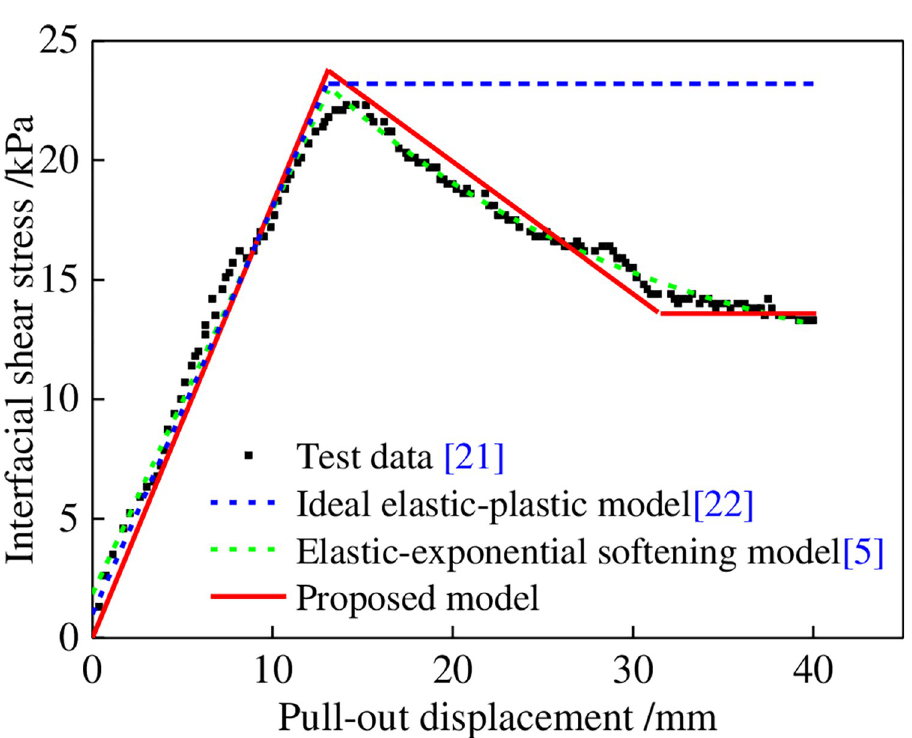
Fig 14. Comparative analysis of the model presented in this paper and two classical reinforced-soil interface models.